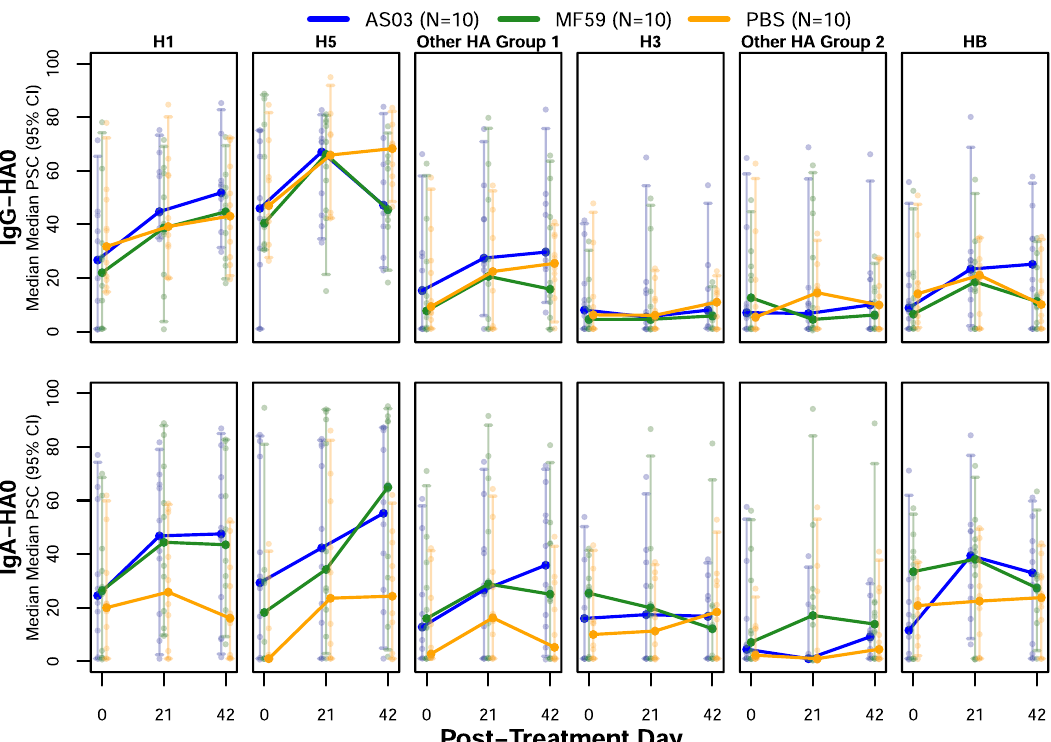
Fig. 9 Median average percent anti-stalk blocking results for IgG and IgA antibodies against full-length HA antigens over time. Percent stalk competition (PSC) for each sample and antigen was calculated as: 100 − (AUC with competition (mini-HA added)/AUC without competition (RSV-F negative control added) × 100) where the AUC represented the area under the curve for fl uorescence intensity for two different concentrations of mini-HA (10 µg and 50 µg/mL). For each subject, PSC values were then aggregated across antigens for the respective antigen group using the mean. For each vaccine group ( n = 10 each), the median AUC was determined. The error bars represent the 95% bootstrap con fi dence interval of the median. Dots represent individual average PSC results for each subject and time